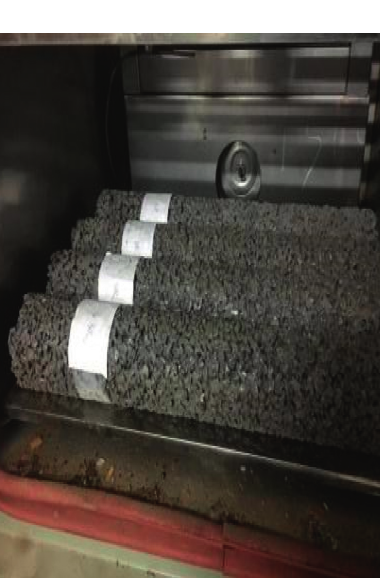
Figure 4: Specimens in the freeze-thaw chamber.